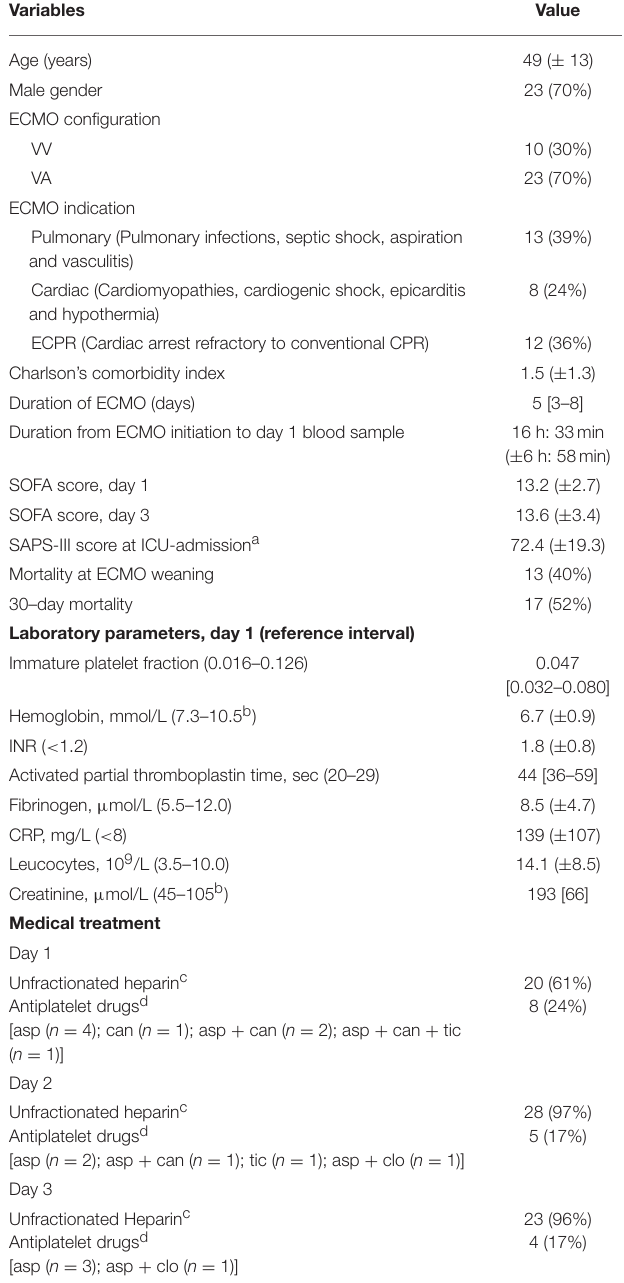
TABLE 1 | Demographic and clinical characteristics of 33 adult patients treated with extracorporeal membrane oxygenation (ECMO) on day 1 ( n = 33), day 2 ( n = 29 ), and day 3 ( n = 24).